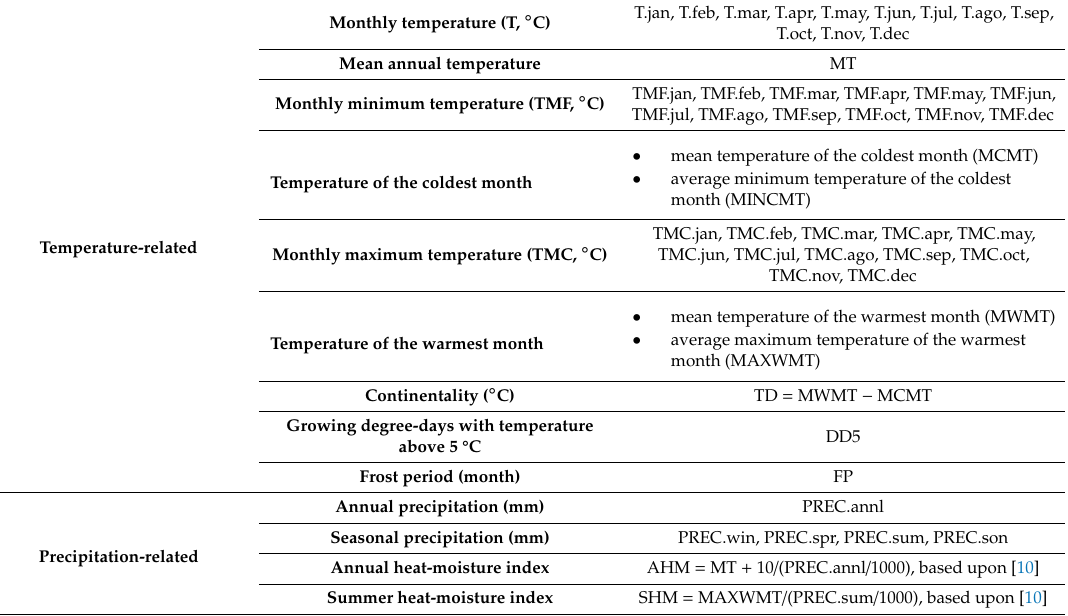
Table 1. Temperature- and precipitation-related climate variables considered in the present